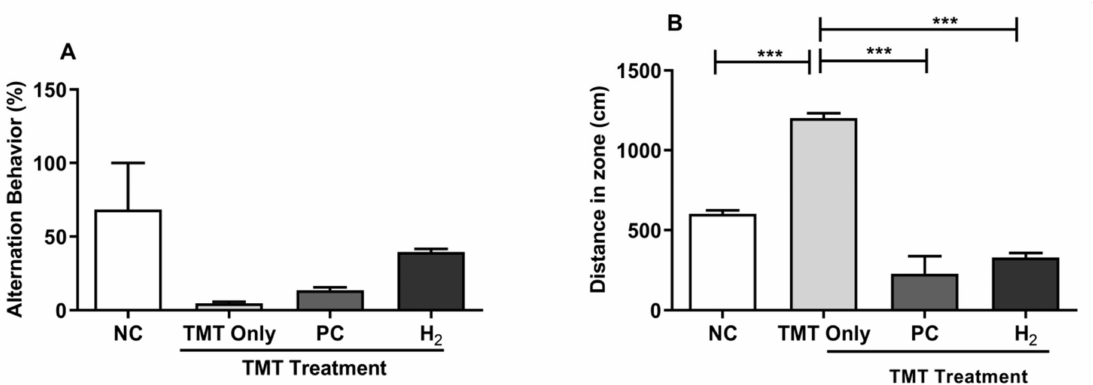
Figure 3. Effects of H 2 gas inhalation treatment on TMT-induced spatial cognitive impairment in C57BL/6 mice. After TMT induction (2.6 mg/kg body weight), 2% H 2 gas and lithium chloride (PC, 50 mg/kg body weight) were ip administered to six mice. ( A ) Alternation behavior on day 7. ( B ) Distance traveled in the Y-maze compartment. Data are shown as the mean ± SEM for n = 4 mice. Significant differences were analyzed with ANOVA and Tukey’s test. *** p <